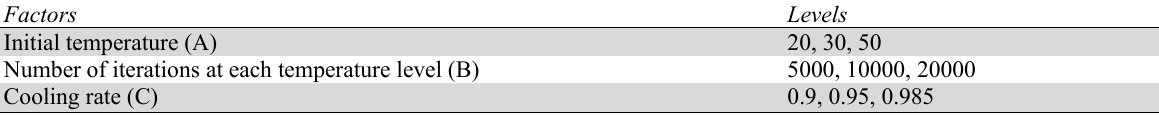
SA parameter levels.